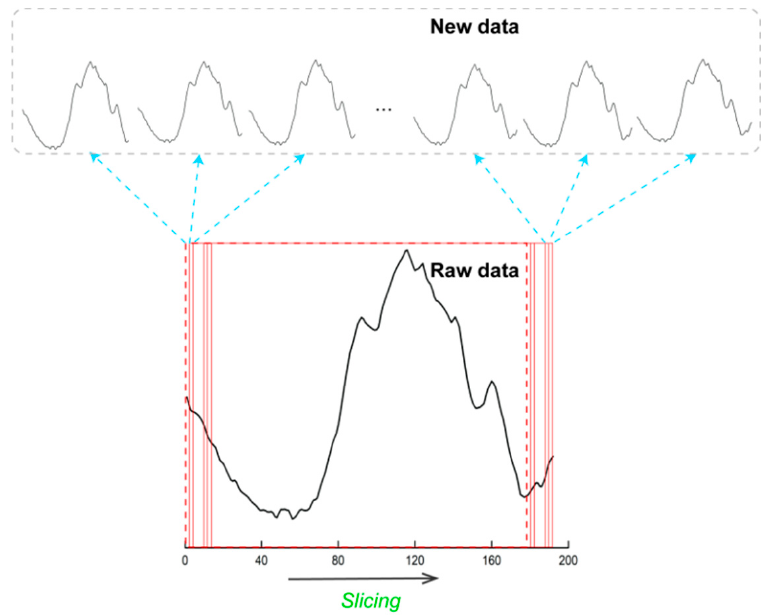
Figure 1. An example to explain the window slicing algorithm. We apply window slicing on CSI data, which is similar to the time series data. For one subcarrier in CSI data C = {C t1 , C t2 , ..., C tn }, a slice is a snippet of the subcarrier in